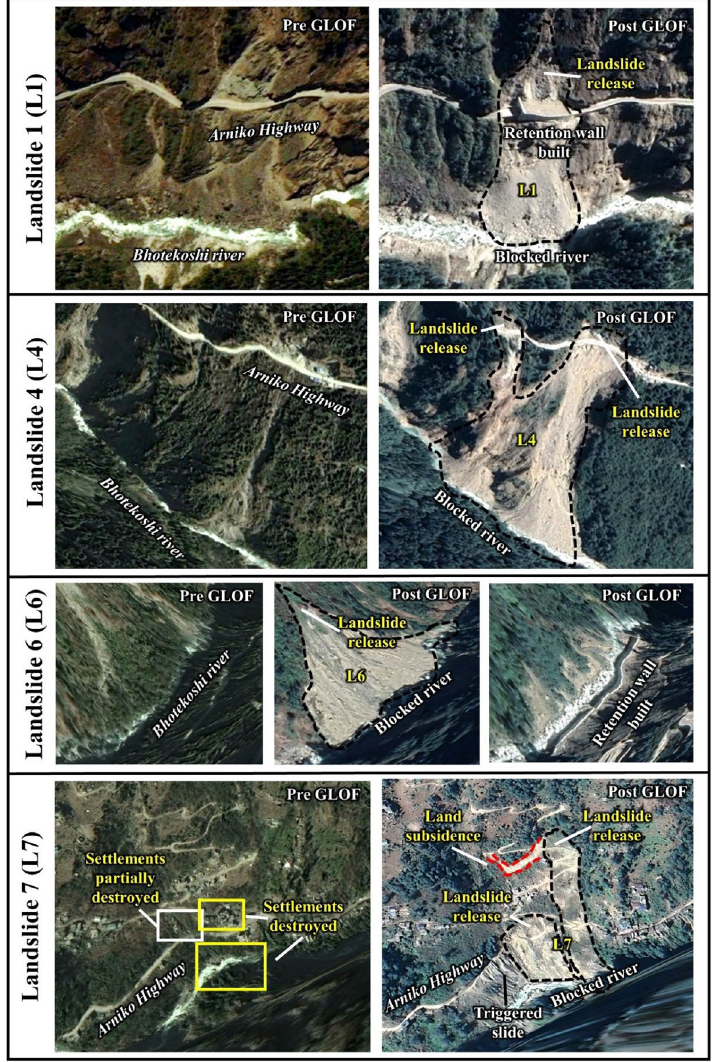
Figure 11. GLOF-induced landslides (L1, L4, L6, and L7) that either damaged the Arniko Highway or blocked the main Bhotekoshi flow channel. Background: Pre- and Post-GLOF imageries from Google Earth (©CNES/ Airbus Maxar